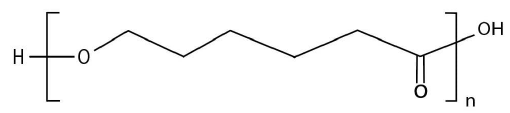
Figure 11. The chemical structure of PCL.